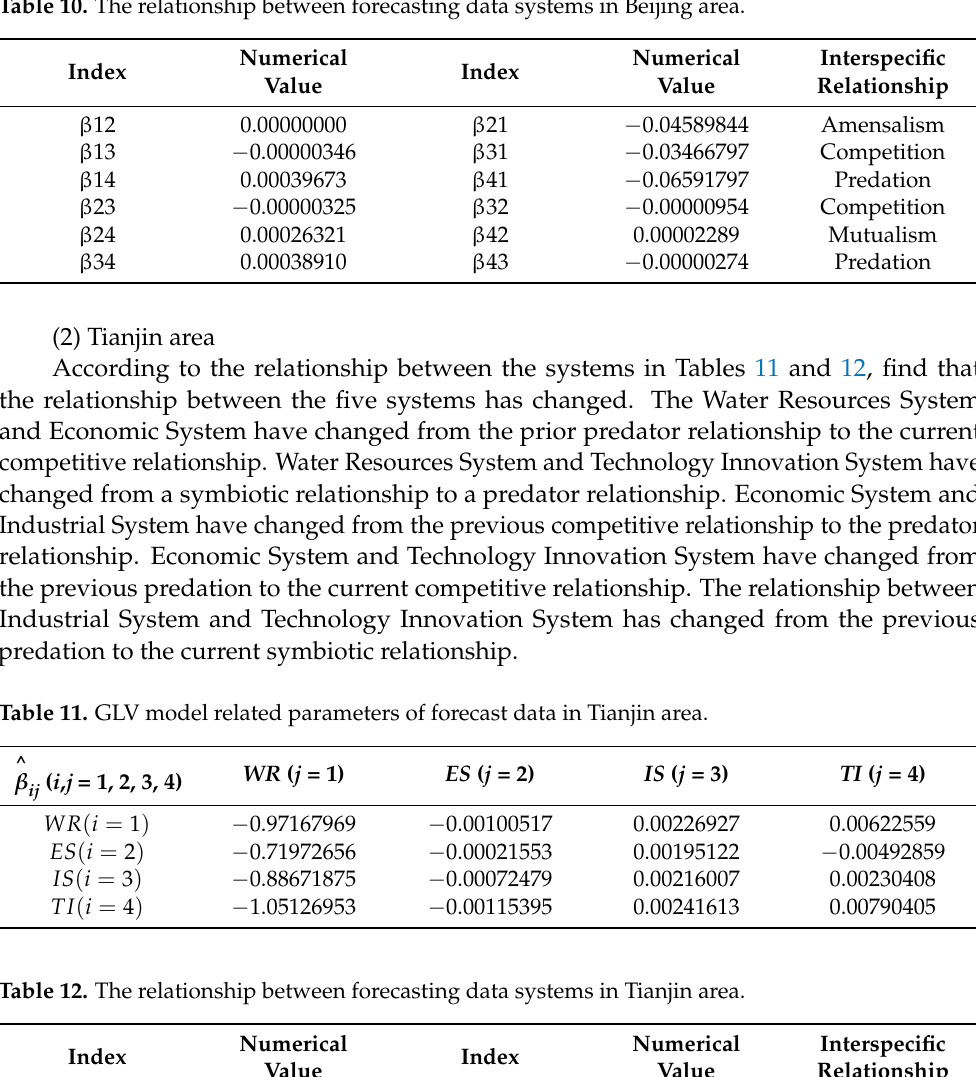
Table 10. The relationship between forecasting data systems in Beijing area.